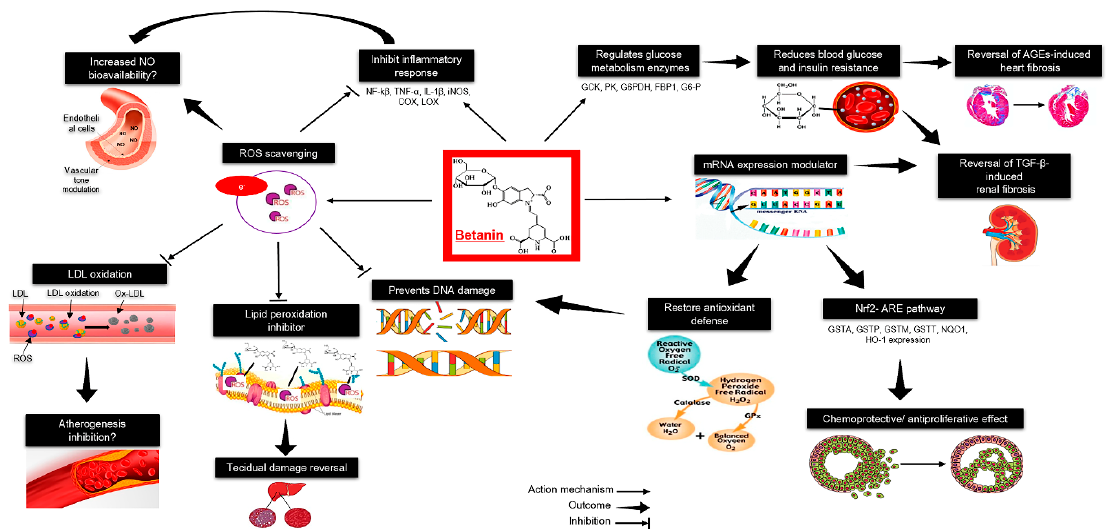
Figure 2. Health effects of betanin: A summary of molecular and metabolic targets of betanin reported in cell cultures and animal models. AGEs, advanced glycation end products; C, carbon; COX, cyclooxygenase; DNA, deoxyribonucleic acid; FBP1, fructose-bisphosphatase 1; G6-P, glucose 6-phosphate; G6PDH, glucose-6- phosphate dehydrogenase; GCK, glucokinase; GPx, glutathione peroxidase; GSTA, glutathione S-transferases A; GSTM, glutathione S-transferases M; GSTP, glutathione S-transferases P; GSTT, glutathione S-transferases T; H, hydrogen; H 2 O 2 , hydrogen peroxide; IL-1 β , interleukin 1 beta; HO-1, heme oxygenase-1; iNOS, inducible nitric oxide synthase; LDL, low-density lipoprotein; LOX; lipoxygenase; mRNA, messenger ribonucleic acid; N, nitrogen; NF- Κ β , nuclear factor kappa beta; NQO1, quinone dehydrogenase 1; NO, nitric oxide; Nrf2-ARE, nuclear factor erythroid 2-antioxidant responsive element; O, oxygen; O2 • − , superoxide anion;